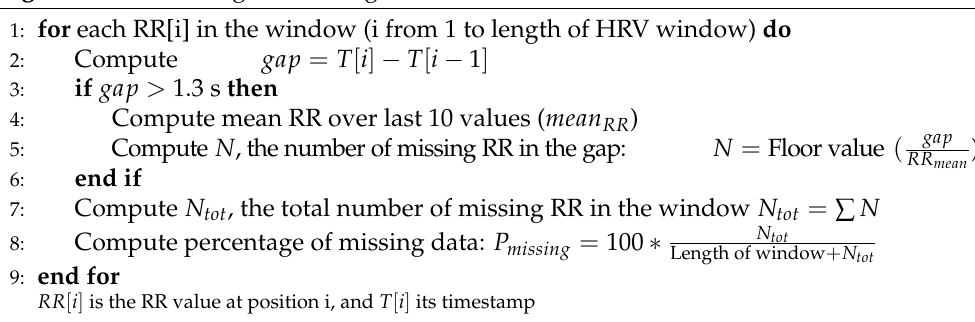
Algorithm 1 Percentage of missing data for each HRV